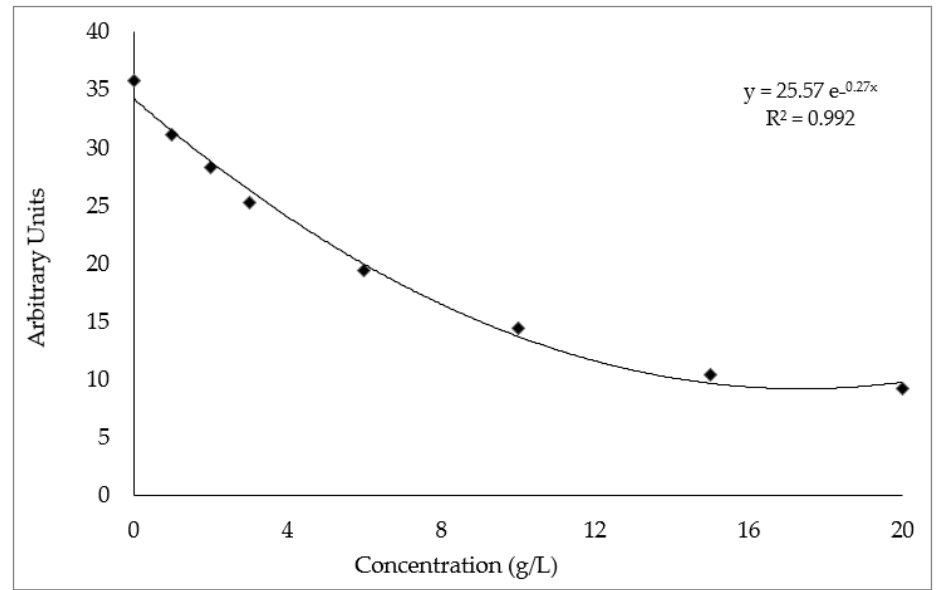
Figure 2. Decrease in the spectrum intensity of the spin adduct of CH 3 O − with the increase in ferulic acid